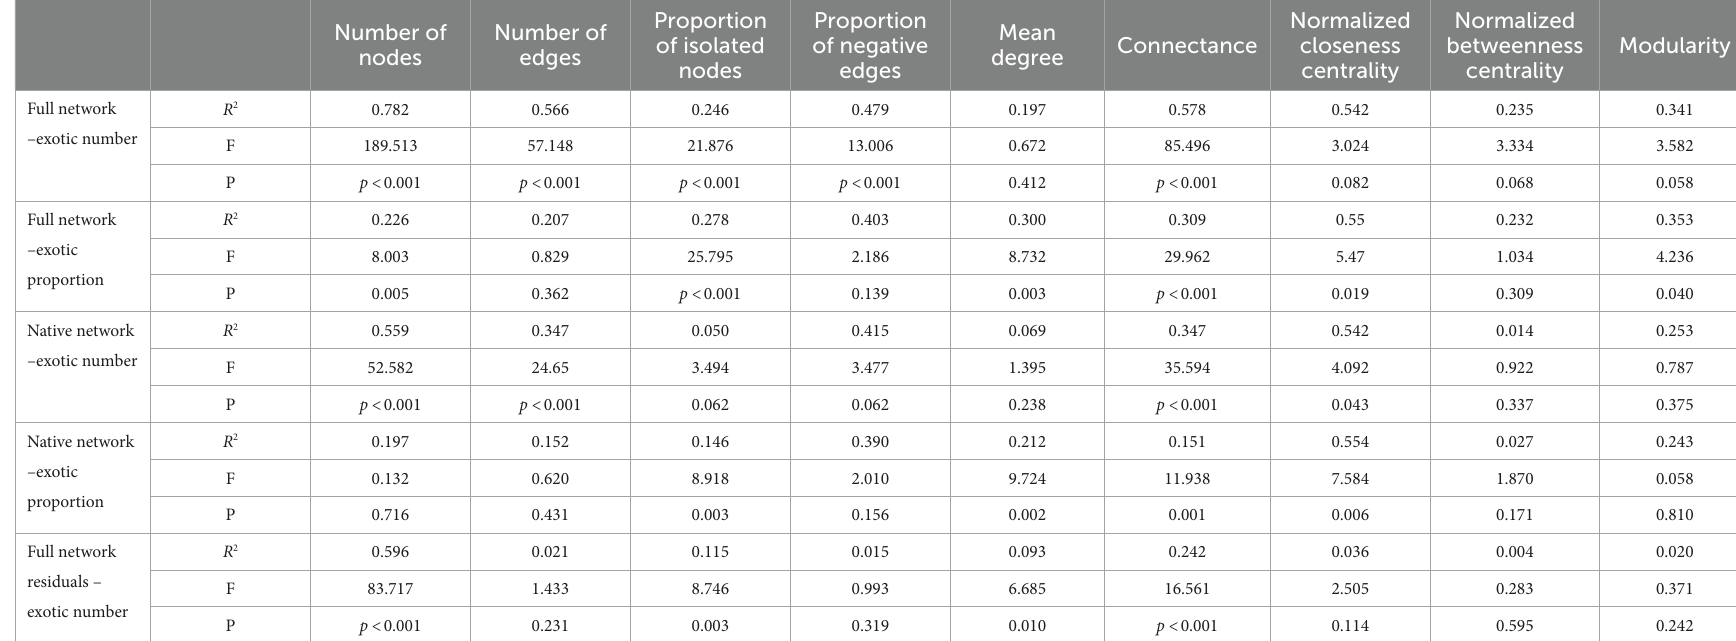
TABLE 1 R 2 , F statistic, and its associated p -values for each network parameter as a function of the number and proportion of exotics in the community.